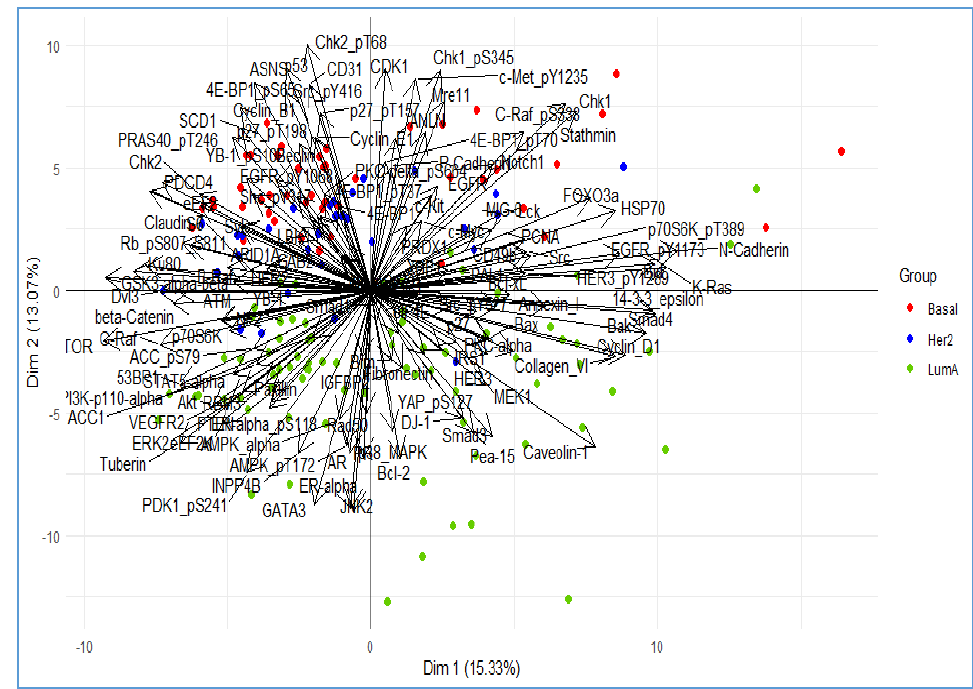
Figure 3. HJ biplot representation.